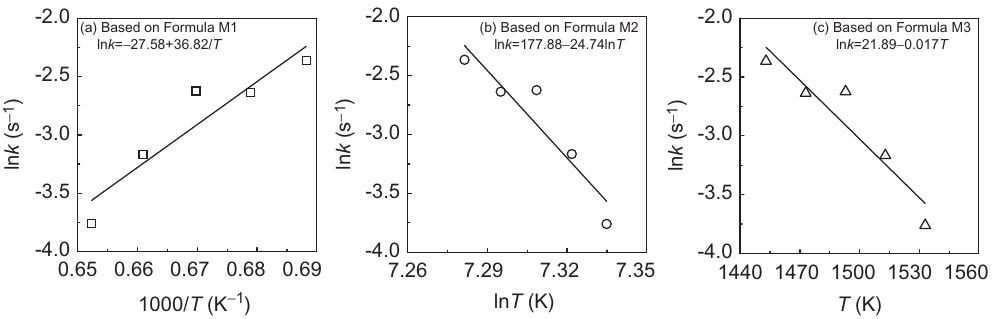
Figure 6: Relationship of crystallization rate constant in natural logarithmic form ln k by three formulas of k against 1 = T (a) or ln T (b) or endpoint temperature T (c) over a temperature range from 1453 to 1533 K,